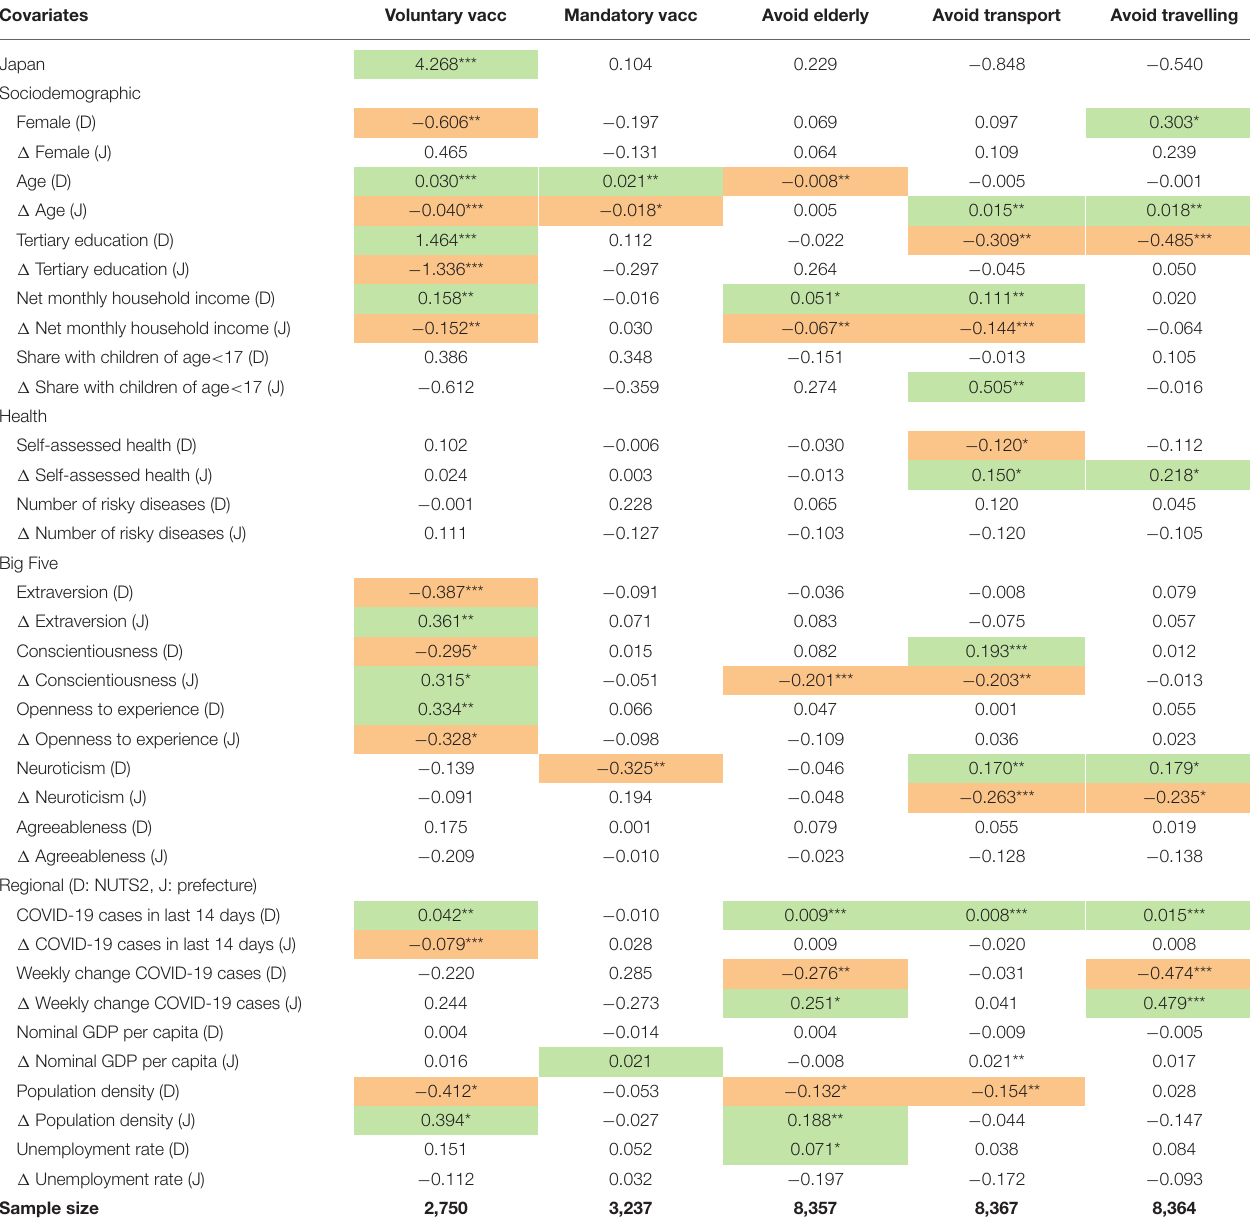
Table 3.1 | Regression coefficients of covariates on attitudes and behavior (1). Covariates Voluntary vacc Mandatory vacc Avoid elderly Avoid